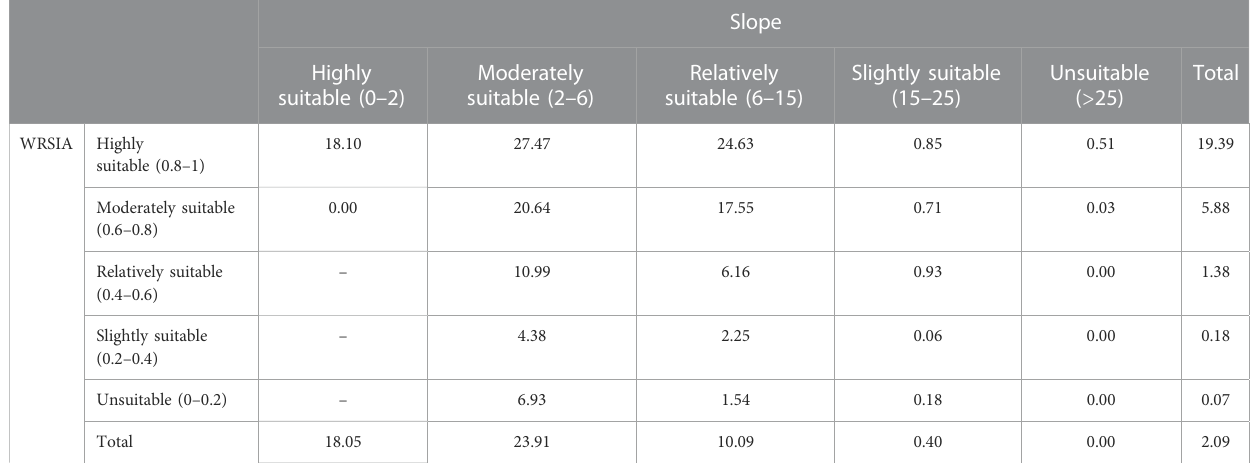
TABLE 3 Cultivated land proportions under different slope grades and WRSIA grades (%).